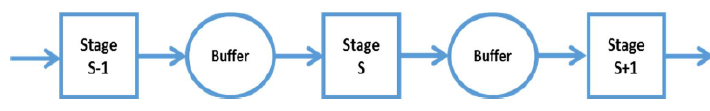
Figure 1. A three-stage production system with two buffer